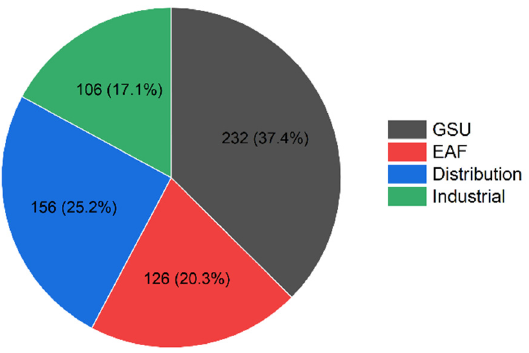
Figure 1. The distribution of operation type of the devices in the study group.